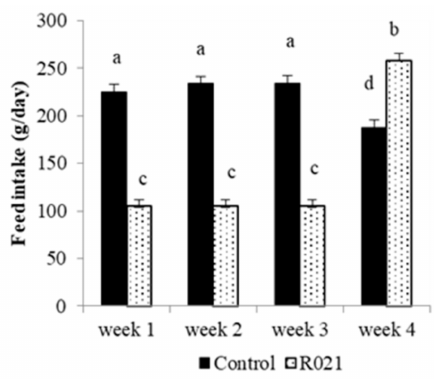
Figure 2. Feed intake (g/day) of pregnant does fed ad libitum (Control group; n = 33) or food restricted (105 g/day) during the two-third of gestation and re-fed ad libitum until term (R021 group; n = 47). Length of gestation is around 31 days. Different letters indicate significant differences between groups and weeks ( p <